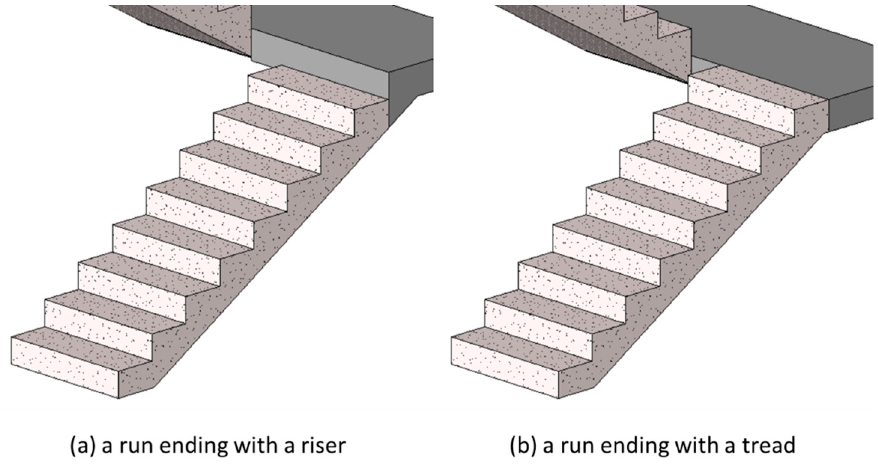
Figure 8. Stairs with risers.